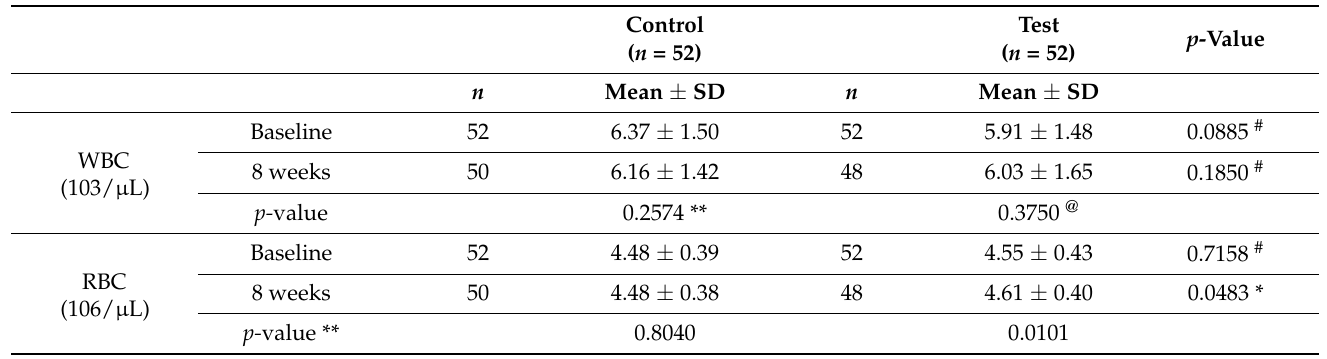
Table 4. Safety analysis of control and test at baseline, 8 weeks (mean ± Figure 2. Biomarkers in salivary sample and gingival crevicular fluid. * Significant difference between test and control ( p < 0.05). GCF: gingival crevicular fluid, IL-1 β : Interleukin-1 β , IL-6: interleukin-6, MMP-9: matrix metalloproteinase-9, MMP-8: matrix metalloproteinase-9.